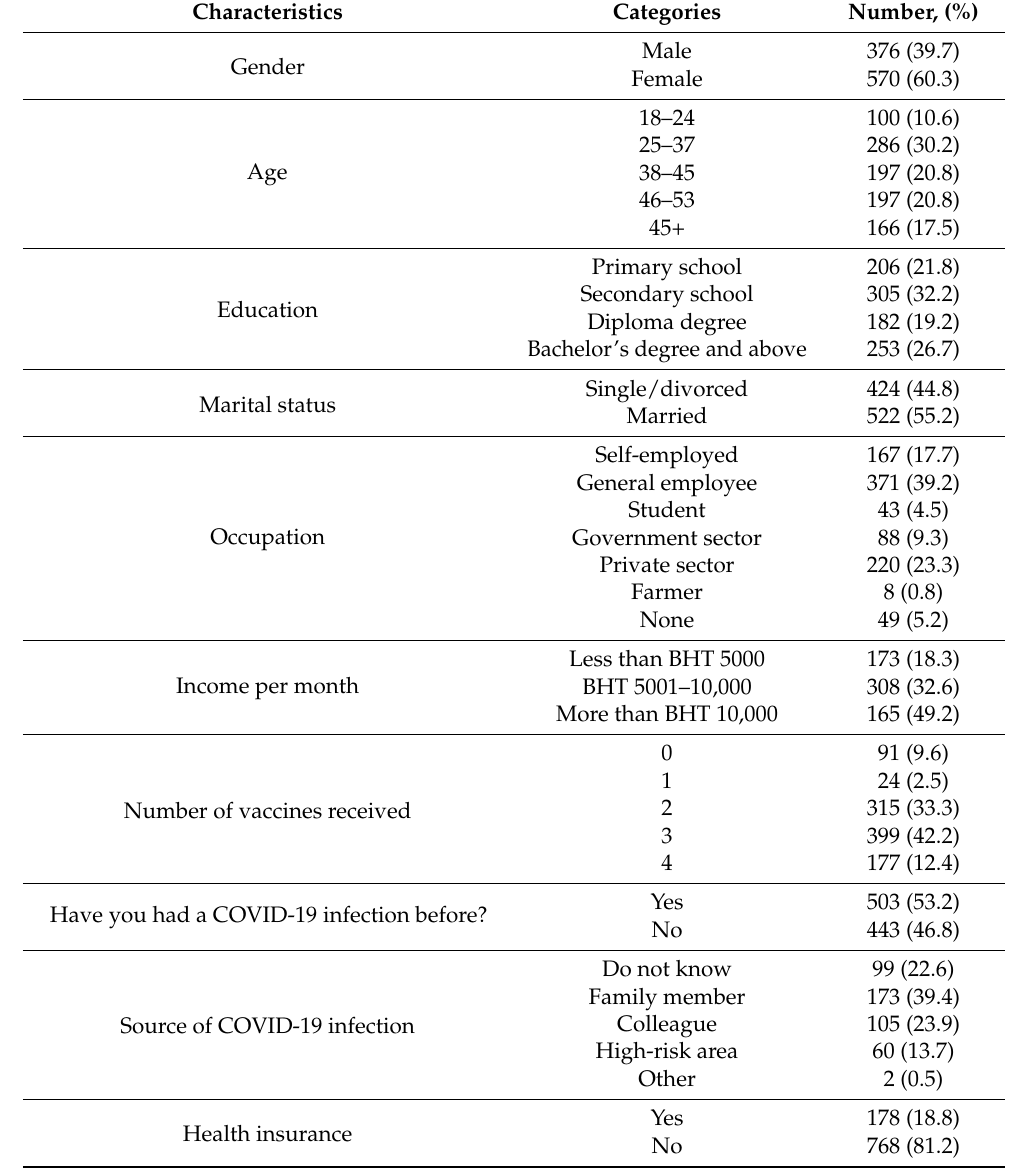
Table 1. Sociodemographic characteristics (N =